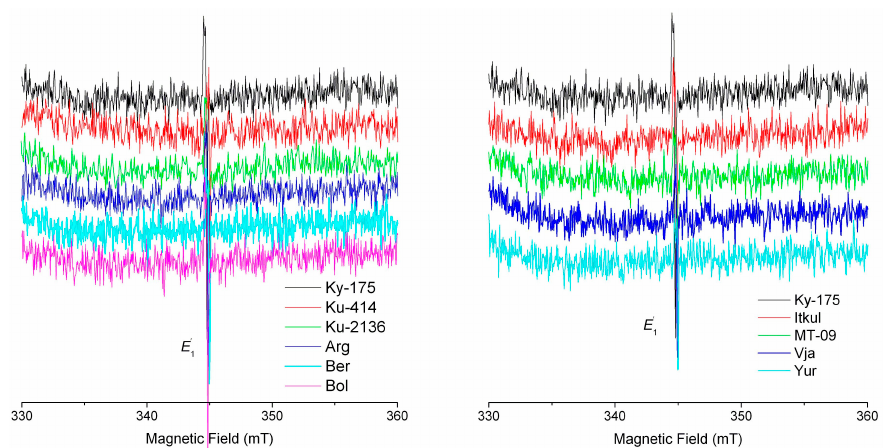
Figure 7. EPR spectra of investigated quartz samples taken at room temperature showing a slight E’ 1 but a general absence of other radiation-induced defects at g eff = 2.0.